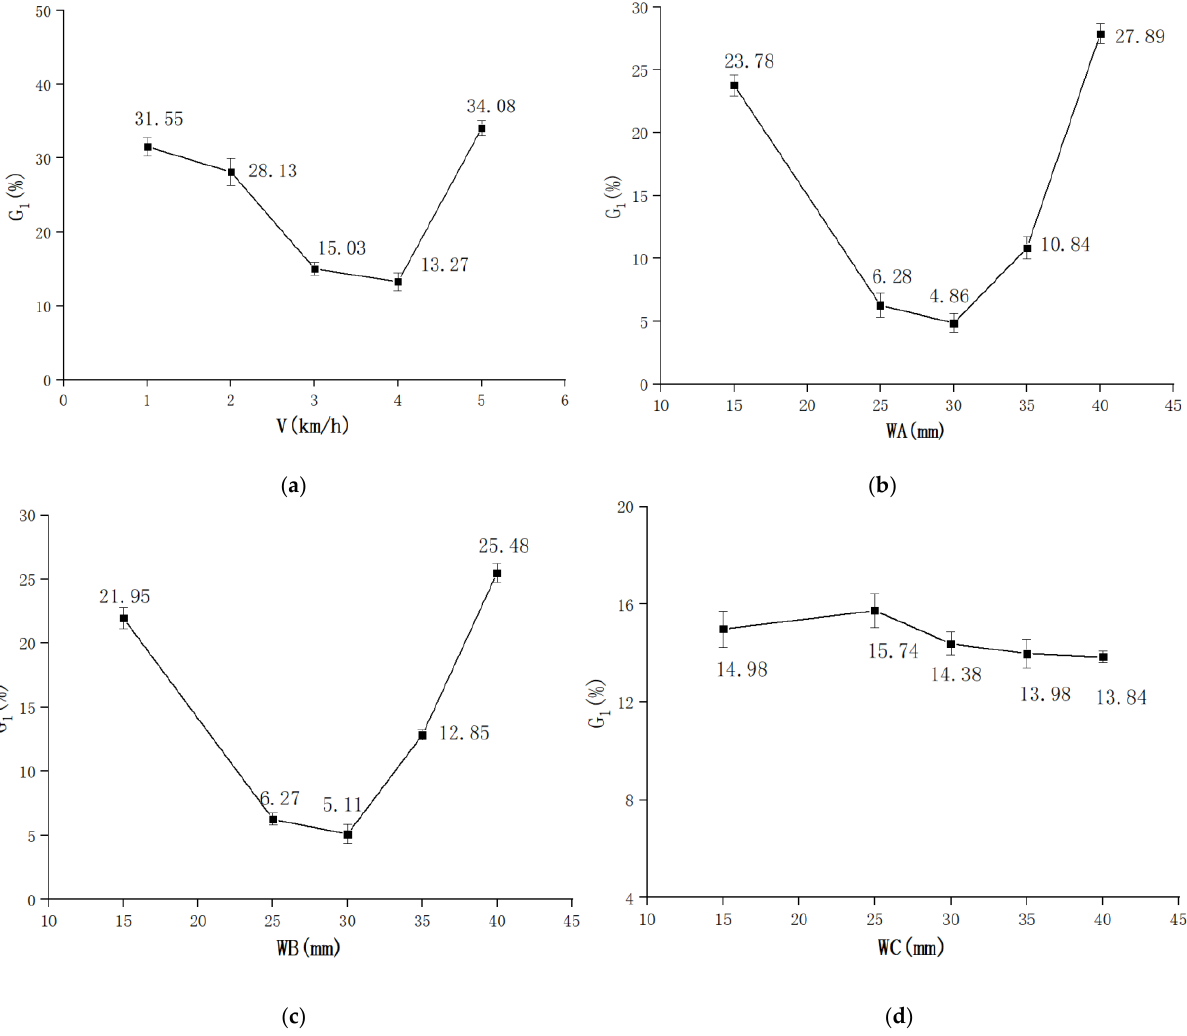
Figure 7. ( a ) Influence of V on G 1 . ( b ) Influence of WA on G 1 .( c ) Influence of WB on G 1 .( d ) Influence of WC on G 1 .